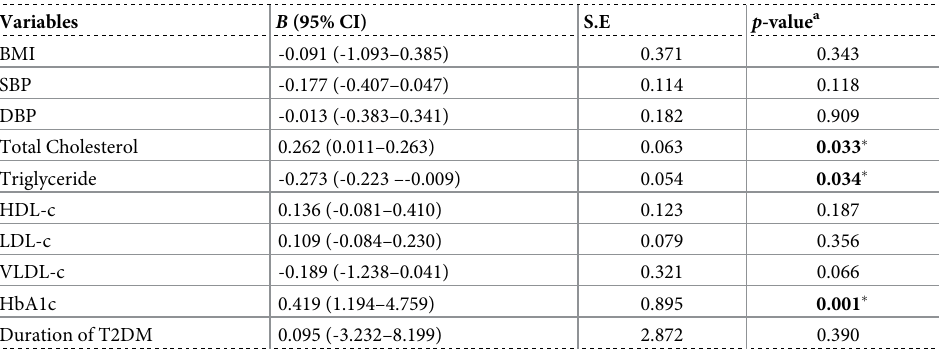
BMI = Body mass index, SBP = Systolic blood pressure, DBP = Diastolic blood pressure, HDL-c = High density lipoprotein cholesterol, LDL-c = Low density lipoprotein cholesterol, VLDL-c = Very low density lipoprotein cholesterol, HbA1c = Glycated Hemoglobin, T2DM = Type 2 Diabetes Mellitus, Β = Regression coefficient, CI = Confidence interval, S.E = Standard error. a p -values were generated by linear regression models. � p -values < 0.05 were considered statistically